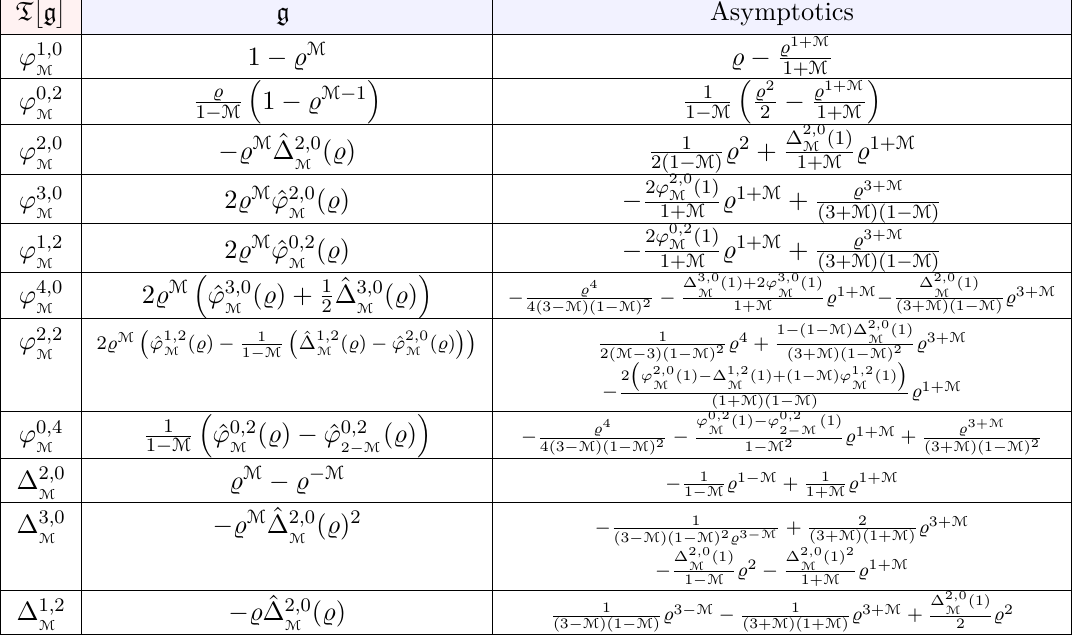
Table 2 . Functions appearing in the gradient expansion of probe Markovian fields of index M in the Reissner-Nordström-AdS d +1 background from [1]. We have expressed the solutions using the integral transform (C.3). The two cases of interest are M = d − 1 which corresponds to minimally coupled scalars (the transverse traceless tensor gravitons) and M = d − 3 which analytically continues to the non-Markovian solutions of index M = 3 − d (with appropriately chosen constants to ensure the quoted asymptotic